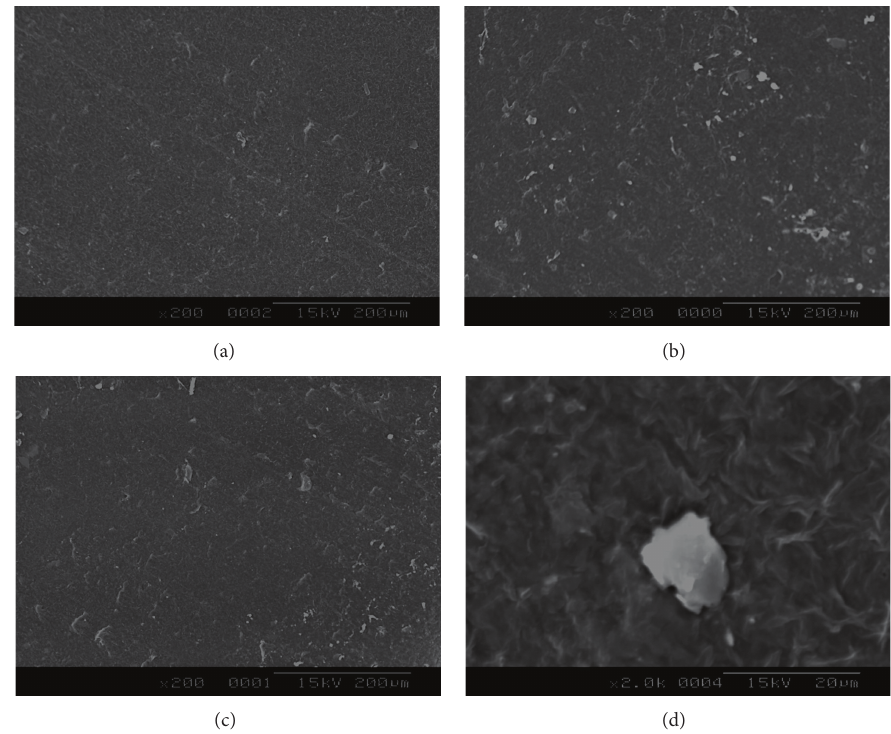
Figure 6: SEM micrographs showing the cell growth over the surface of blend samples without microporosity on surface.